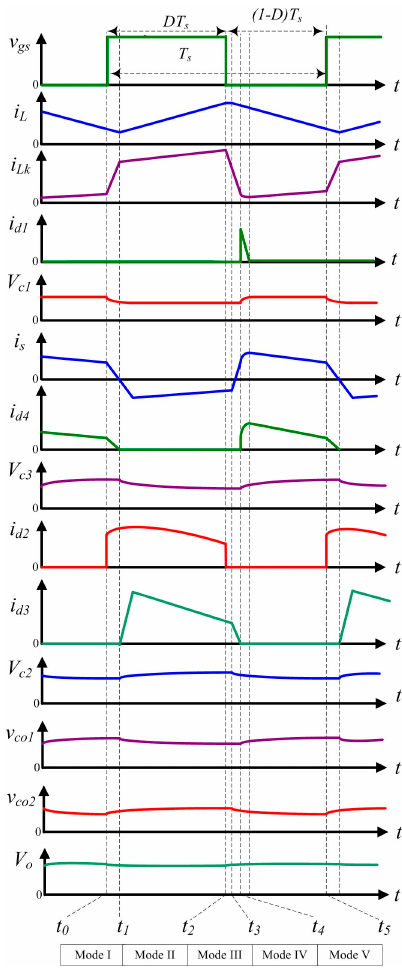
Figure 2. Key components current and voltage waveforms of the proposed converter at CCM.